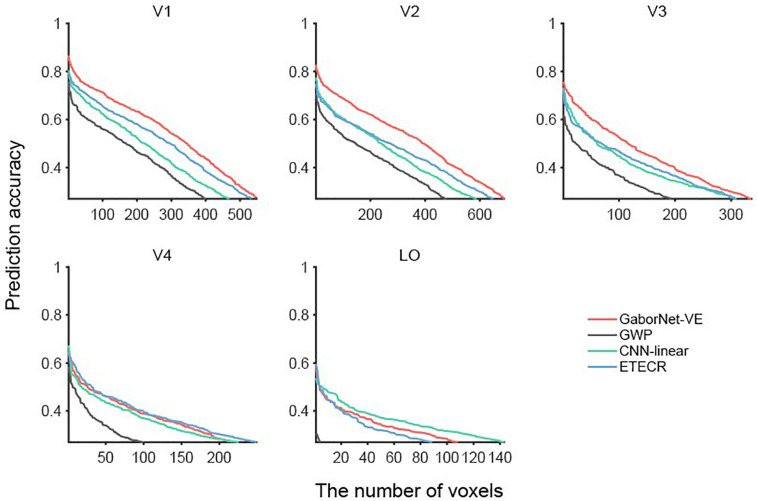
Visualization of the Gabor kernels and RFs. (A) Visualization of Gabor kernels. Each of images in first row includes 64 real Gabor kernels learned by real Gabor convolutional layer in GaborNet-VE model for each ROI. Similarly, each of images in second row includes 64 imaginary Gabor kernels learned by imaginary Gabor convolutional layer in GaborNet-VE model for each ROI. (B) Visualization of RFs and preferred Gabor kernels. RFs of preferred Gabor kernels for each of five representative voxels are plotted. For each ROI, upper image shows RFs, whereas lower image shows eight preferred Gabor kernels. (C) Fitting of RFs to ROIs. Vertical axis represents ratio of RF size to whole image size. Horizontal axis represents five ROIs. (D) Tuning of Gabor kernel parameters to ROIs. Vertical axis represents parameter means for preferred Gabor kernels and top 100 best voxel predictions. Blue, orange, green, and red curves represent means of parameters ω, σ, φ, and θ, respectively. Horizontal axis represents five ROIs.